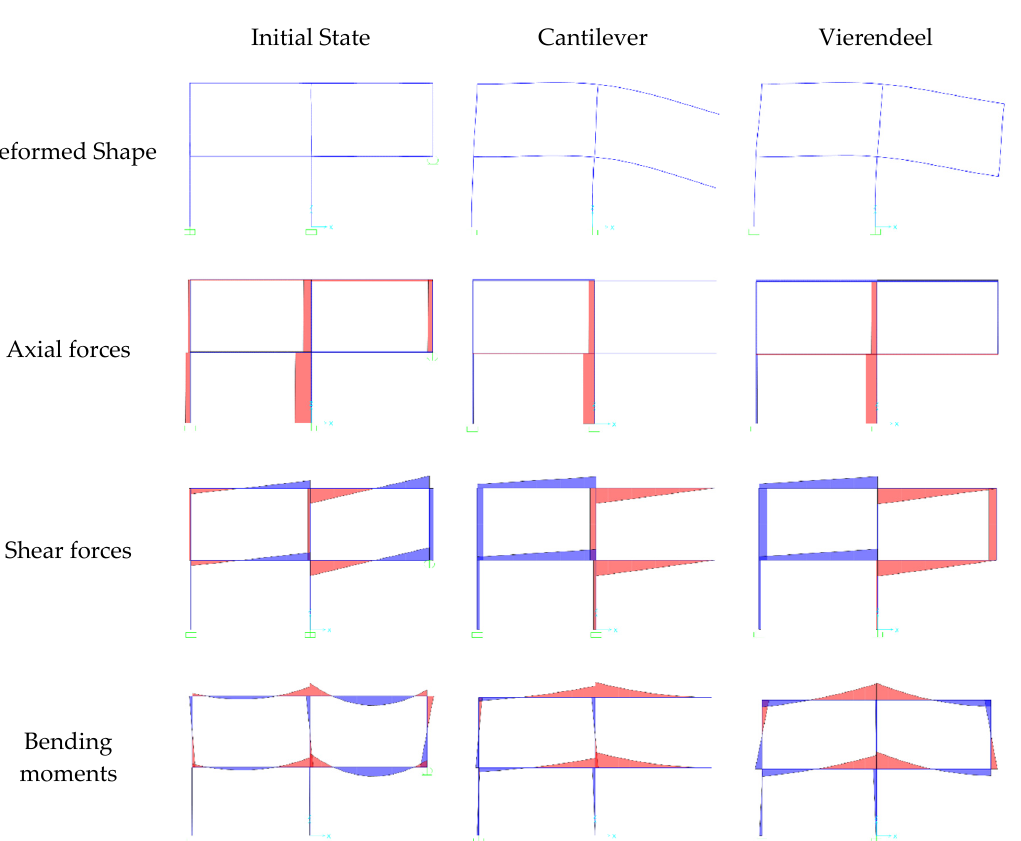
Figure 12. Conceptualisation of static column removal effects (deformed shape, axial and shear forces and bending moments) of the building under study in design situations before (initial state) and after (cantilever and Vierendeel) column removal.